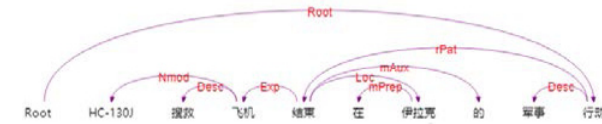
Fig. 3. A Chinese example of semantic dependency